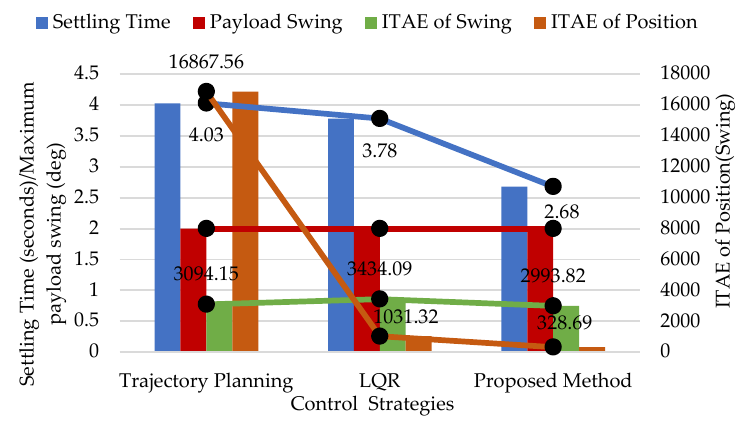
Figure 8. Performance of three controllers.